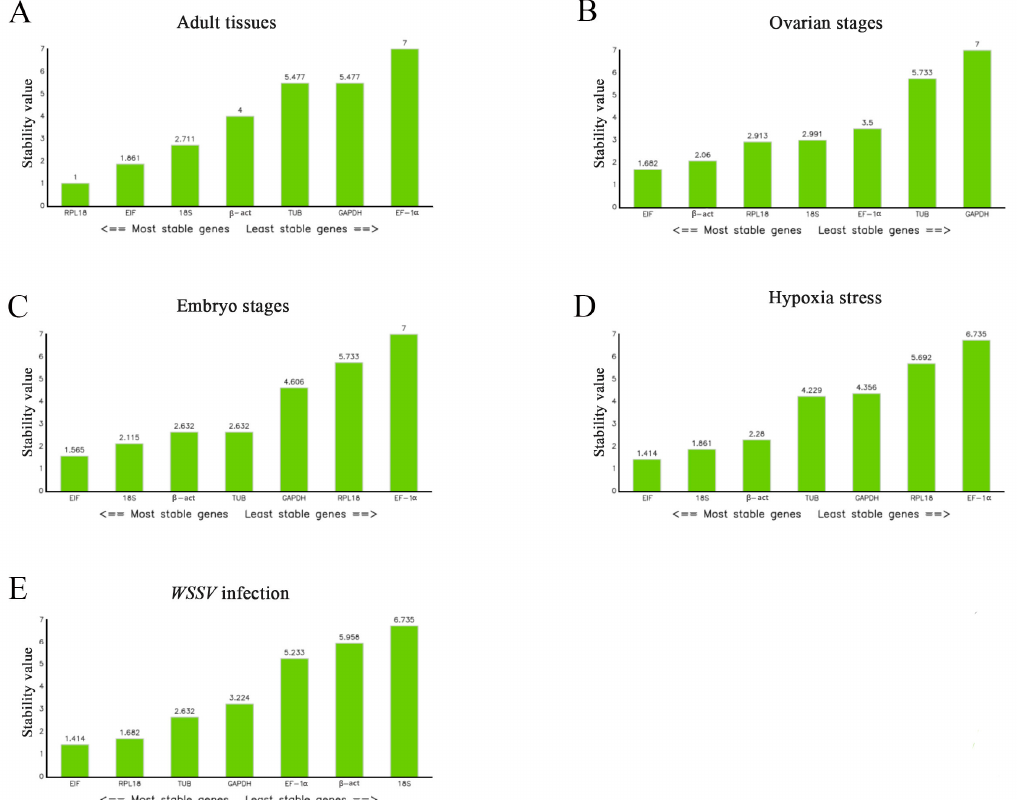
Figure 5. Comprehensive ranking of the reference genes under different conditions by RefFinder. ( A ) Different tissues in adult shrimps. ( B ) Five different ovary development stages. ( C ) Different embryo development stages. ( D ) Different times after hypoxia stress in gill. ( E ) Different times after infection in hepatopancreas. From left to right means the most suitable to the least suitable.